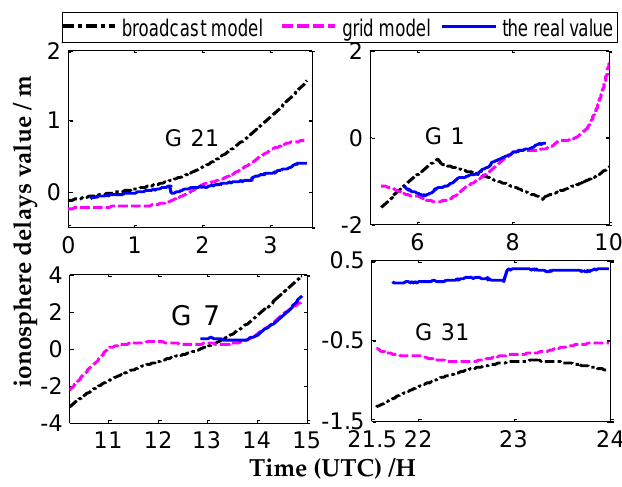
Figure 7. The ionosphere delay values under three ionosphere methods of TLSE and WTZR.